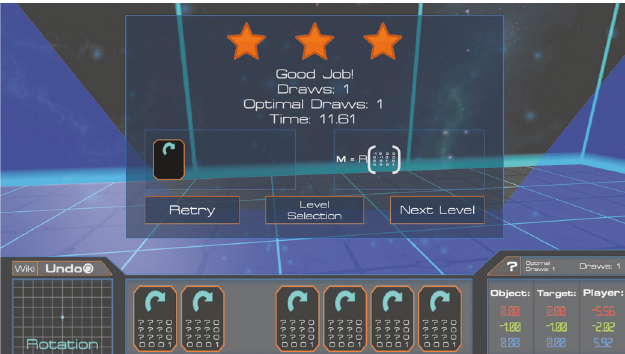
Figure 7: The debriefing screen provides information about a player’s gameplay performance and displays the mathematical equation of the used